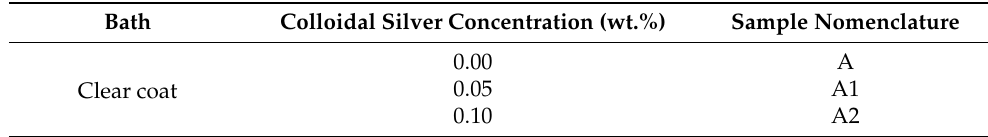
Table 1. Labeling of samples with different colloidal silver concentration. Bath Colloidal Silver Concentration